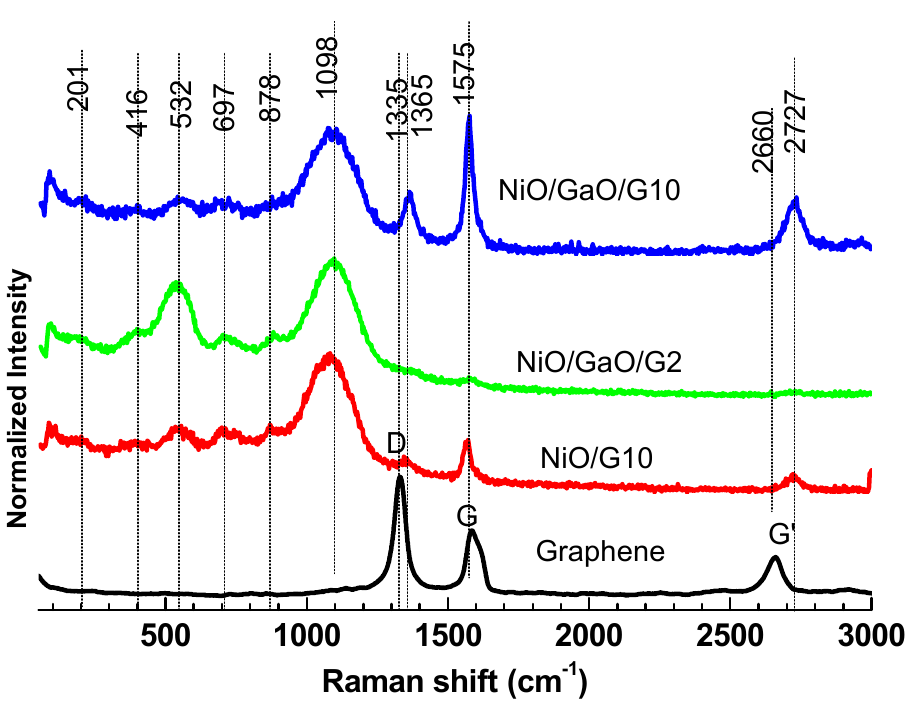
Figure 5. Raman spectra as-prepared graphene, NiO/G10, NiO/Ga 2 O 2 /G2, and NiO/Ga 2 O 2 /G10 nanocomposites.